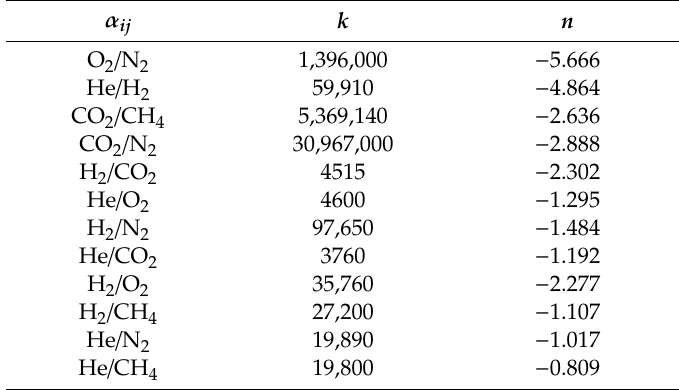
Table 1. Values of the front factor and the upper bound slope for the di ff erent gas pair separations. (adapted from [14,15]). α ij k n O 2 / N 2 1,396,000 − 5.666 He / H 2 59,910 − 4.864 CO 2 / CH 4 5,369,140 − 2.636 CO 2 / N 2 30,967,000 − 2.888 H 2 / CO 2 4515 − 2.302 He / O 2 4600 − 1.295 H 2 / N 2 97,650 − 1.484 3760 − 1.192